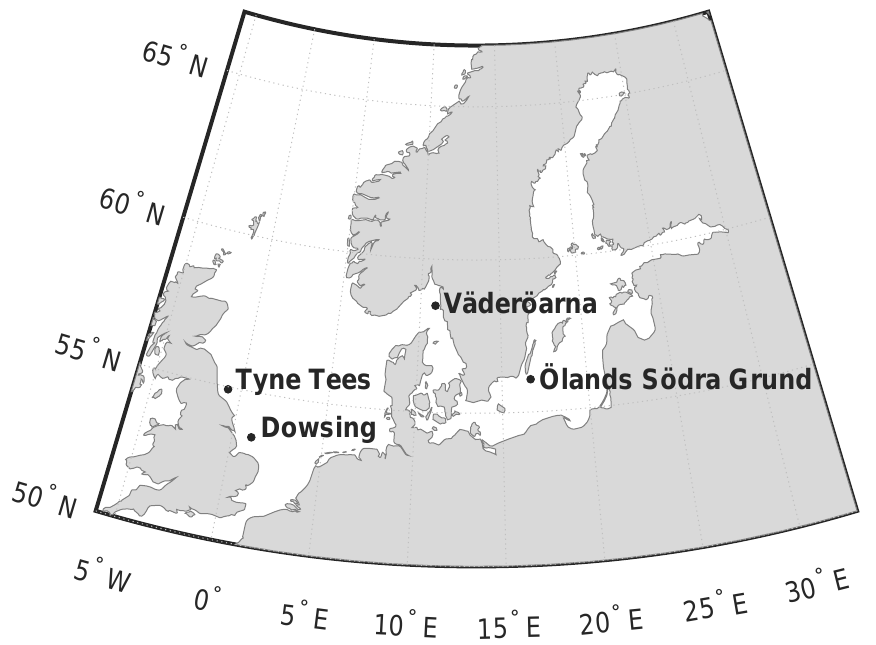
Figure 2. The four sites considered in this study. Table 1. Properties of the four sites considered in this study. The water depth and the distance to the closest coast are shown. The mean significant wave height is denoted H s and is given for the observational and hindcast data sets. Also shown is the data availability, in years, for the